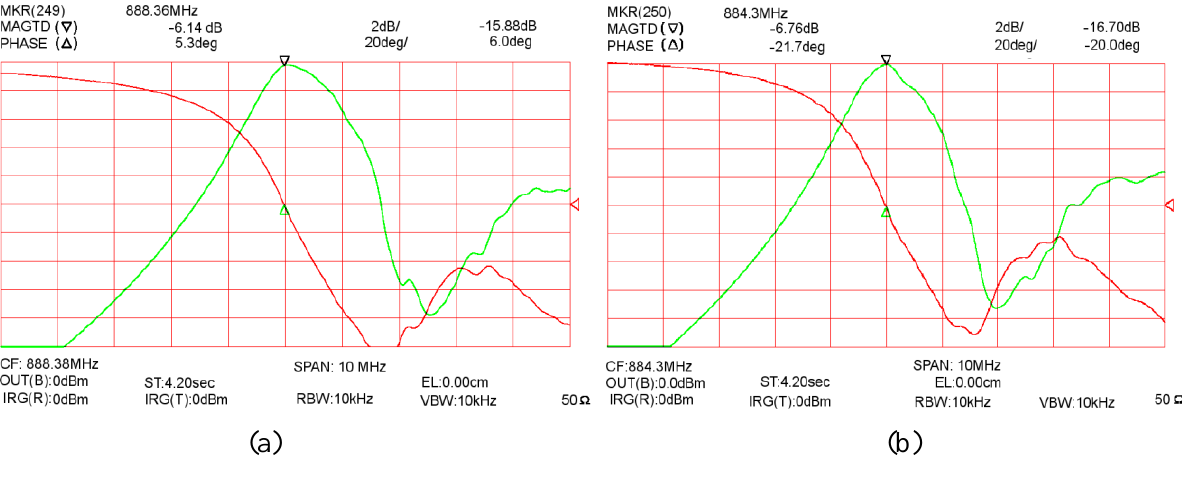
Figure 10. Frequency response of the 75 nm HMDSO coated FPAR ( a ) Wide frequency range measurements ( b ) FEM calculated close to resonance